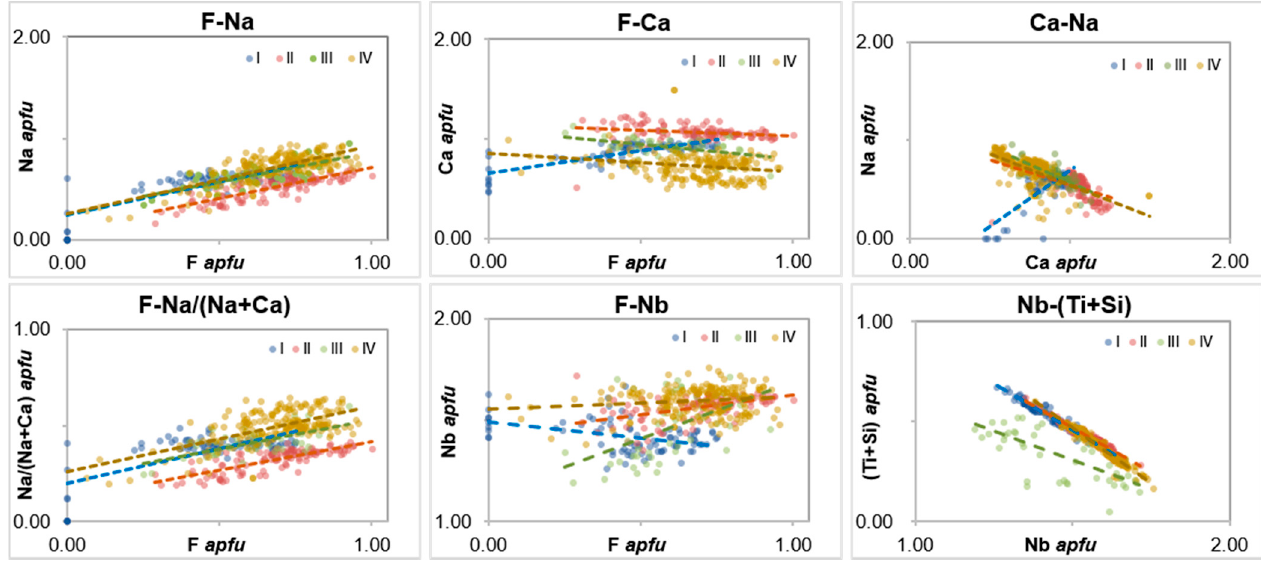
Figure 17. Binary plots illustrating the compositions ( apfu ) of the pyrochlore group minerals from the Huili